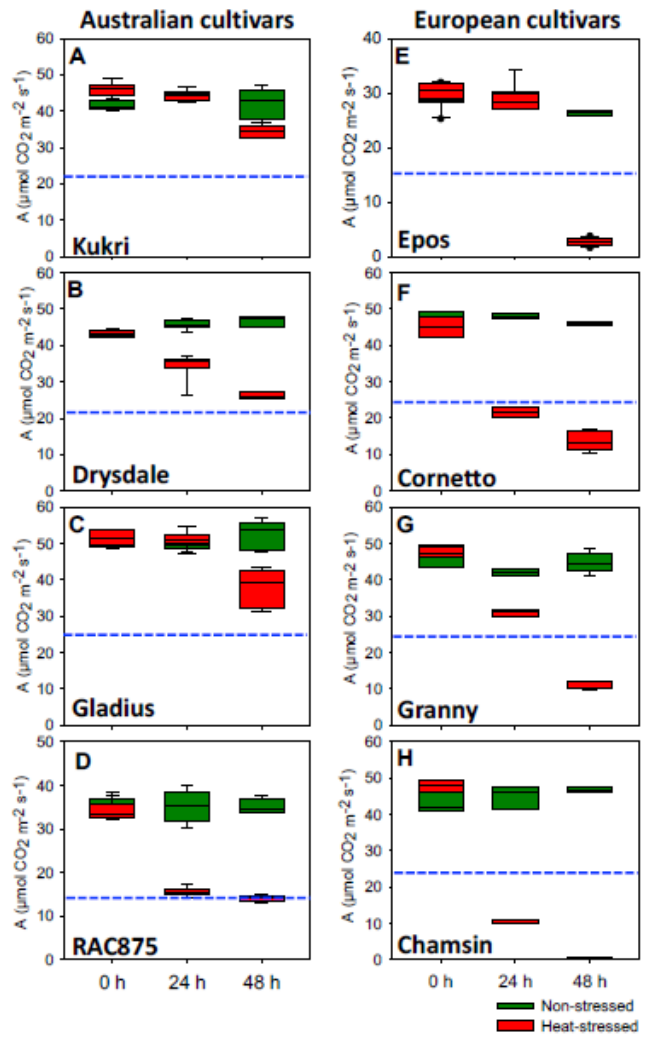
Figure 3. Effect of moderate heat stress on net photosynthesis rates of Australian ( A – D ) and European ( E – H ) summer wheat varieties during the pollen division stage. Box plots show the central tendency and dispersion of the net photosynthetic rate among all Australian and European wheat cultivars. Green and red box plots represent non ‐ and heat ‐ stressed plants, respectively. Blue bars show 50% net photosynthesis rates of non ‐ stressed plants for comparison. 15–20 plants of each line were examined.